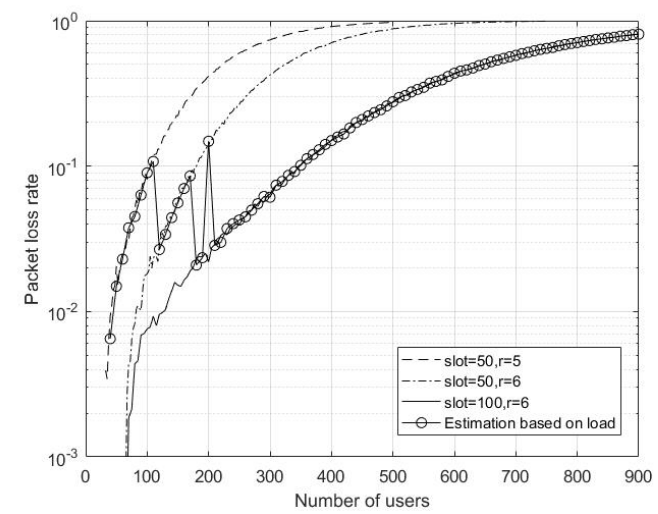
Figure 14. Simulation curve of packet loss rate performance of improved protocol.